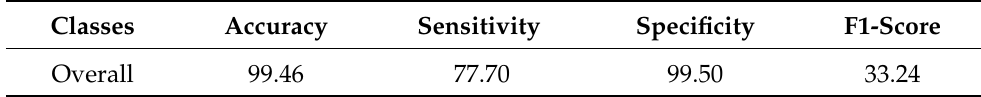
Table 4. Prediction results of proposed CNN on testing data.